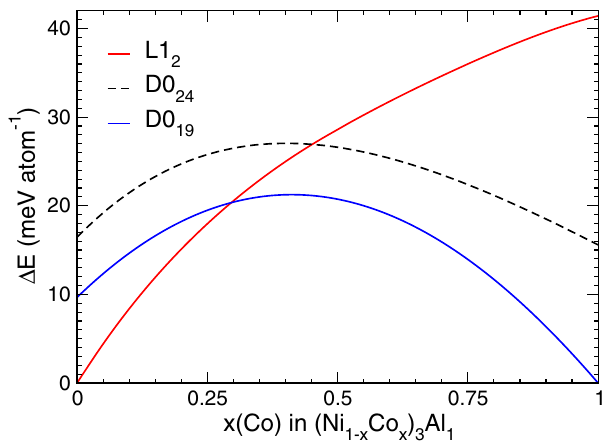
Fig. 7 DFT predicts Co segregation on Ni sites along SSFs. Mixing energy ( Δ E) of (Ni 1-x Co x ) 3 Al 1 in L1 2 ( γ ʹ ), D0 19 ( χ ), and D0 24 ( η ) structures are predicted by DFT to be concave versus composition; this points at Co segregation tendency along SSFs on Ni-sites. The computed VASP formation energies of Ni 3 Al (Co 3 Al) are − 0.4477, − 0.4381, and − 0.4313 eV atom − 1 ( − 0.1652, − 0.2066, and − 0.1910 eV atom − 1 ) in L1 D0 19 , D0 24 phases,